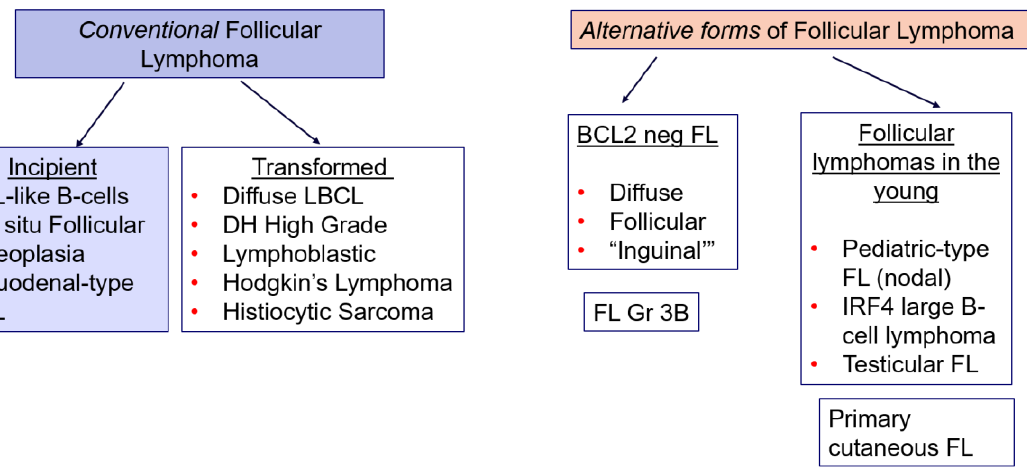
Figure 1. Evolving spectrum of follicular lymphoma.